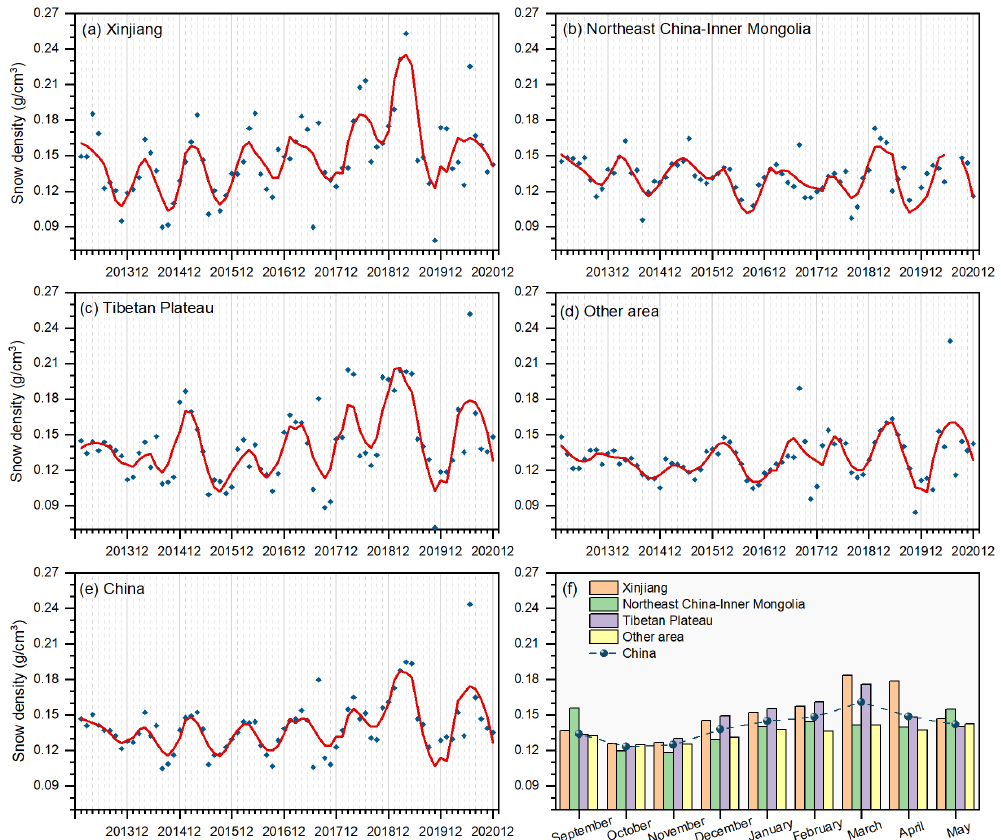
Figure 9. Mean snow density in each month of the snow season from January 2013 to December 2020 in different snow cover regions, including Xinjiang (a) , Northeast China–Inner Mongolia (b) , the Tibetan Plateau (c) , other area (d) , and the entire study area (e) , as well as the monthly mean snow density of the 8 years (f)